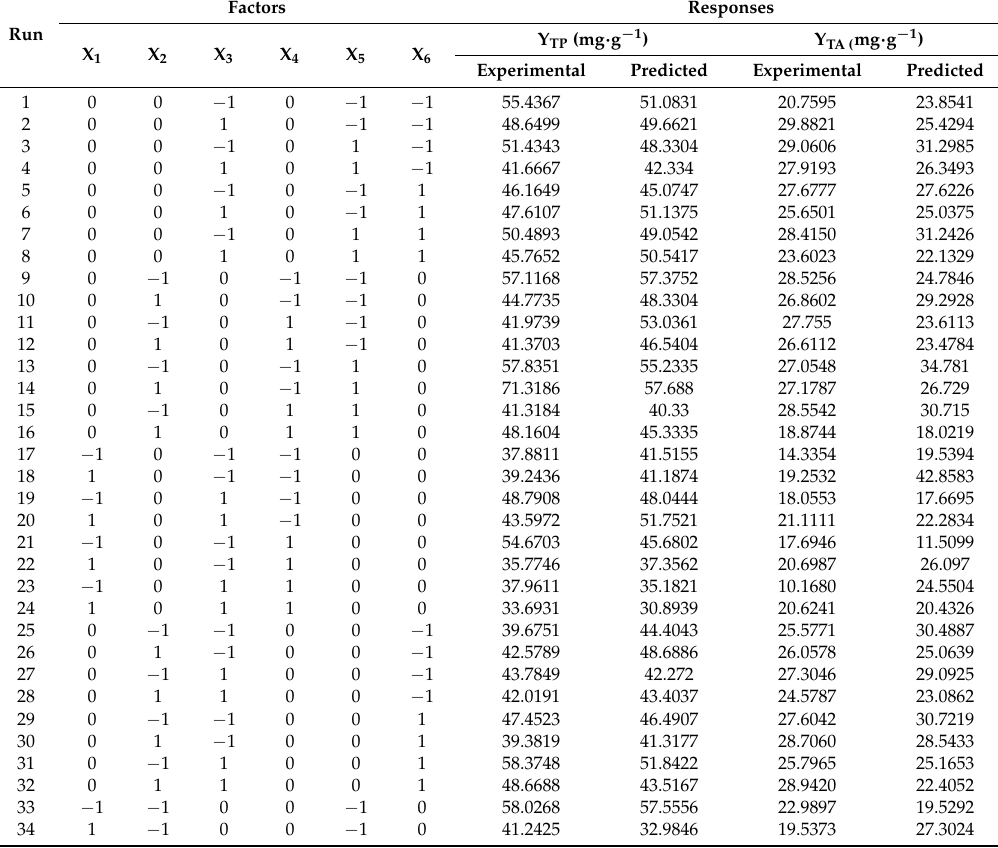
Table 5. Experimental and predicted values for total phenolic compounds and total anthocyanins contents based on Box–Behnken